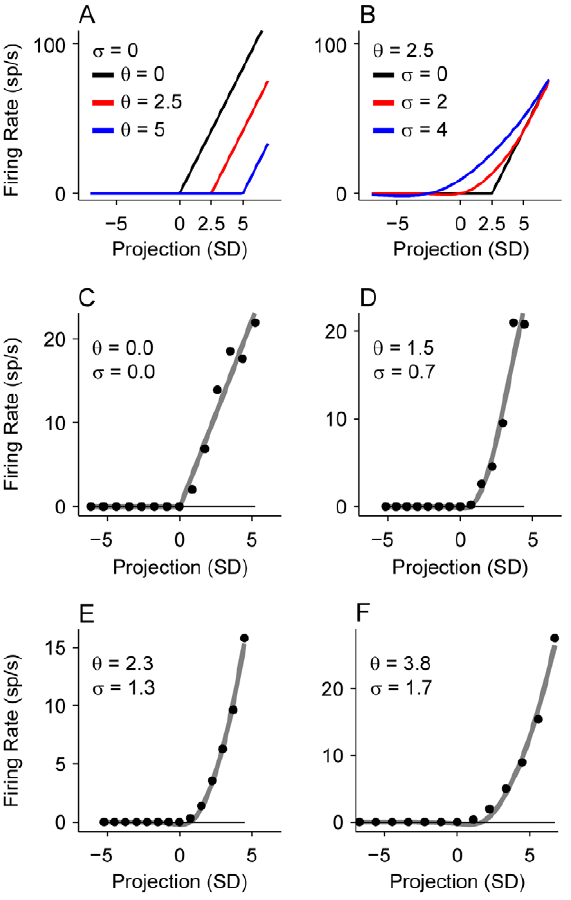
Figure 11. Parametric analysis of STRF nonlinearities. (A) Example parametric curves. In these examples the transition noise s is set to 0, and the threshold h is varied. (B) Example parametric curves with the threshold h held constant at 2.5 and the transition noise s varied. (C–F) Example nonlinearities from data (black dots) and corresponding parametric curve fits in gray. Threshold and transition values for each curve fit are shown in insets as h and s .